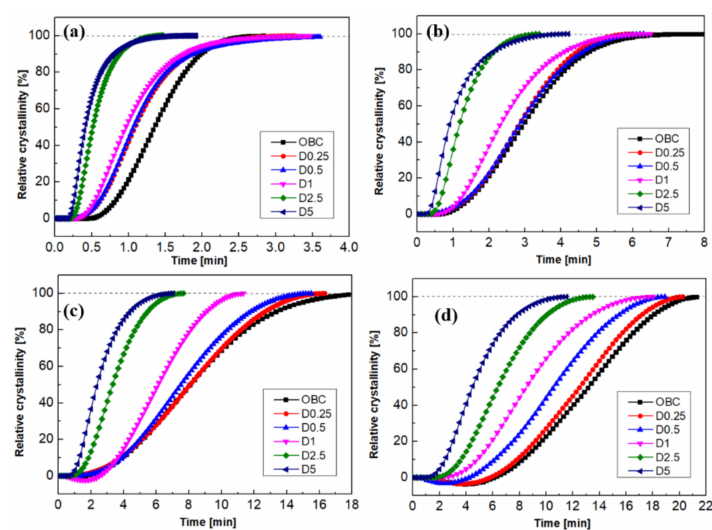
Figure 4. Evolution of the relative crystallinity X t for OBC/DMDBS composites with different DMDBS contents during isothermal crystallization processes at different temperatures of ( a ) 110 ◦ C ( b ) 112 ◦ C ( c ) 114 ◦ C and ( d ) 115 ◦ C.